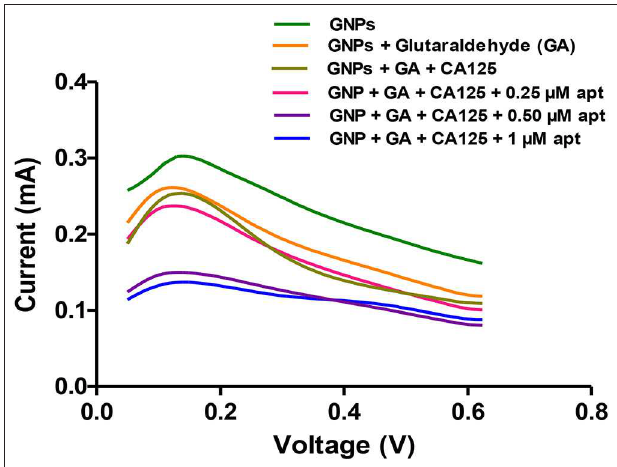
FIGURE 7 | Apt 2.26-CA125 binding using differential pulse